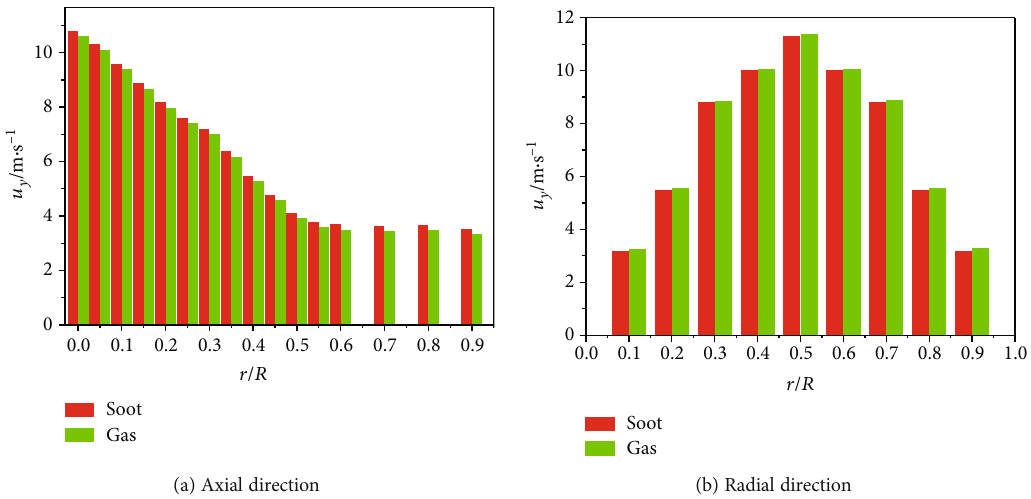
Figure 7: Comparison chart in section B-B between the soot velocity and the gas velocity.